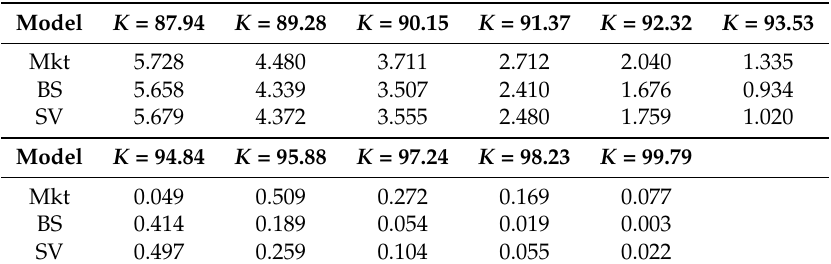
Table 5. Results of option prices on the YEN–USD FX rate from the Black-Scholes (BS) model, the SV model, and the market.